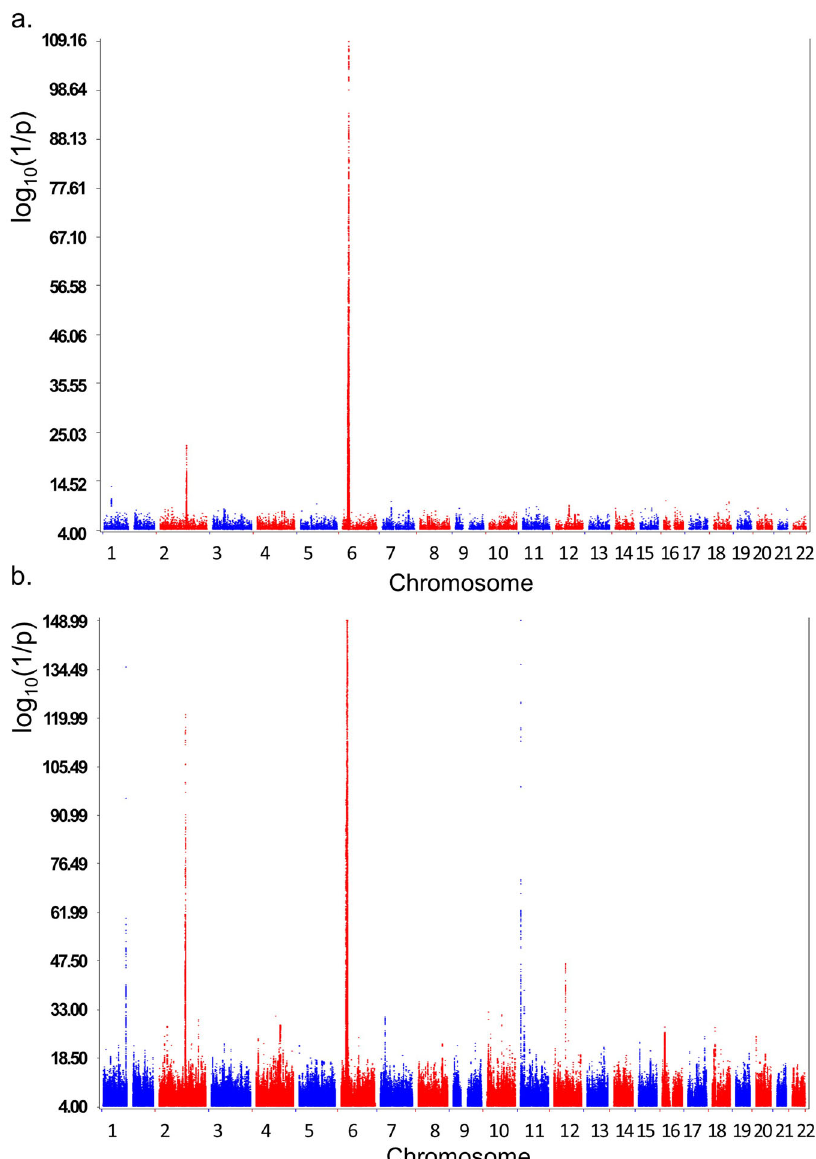
Fig. 1 The Manhattan plots of this study. a the GWAS of T1D patients with low T1D GRS (957 cases vs. 12,350 controls); ( b ) The plot of the GWAS of all T1D patients (6599 cases vs. 12,350